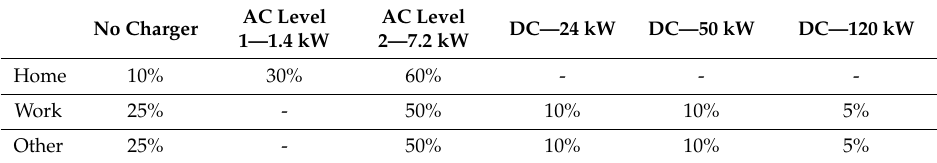
Table 9. Charging Infrastructure Assumptions 2030 (unmanaged).